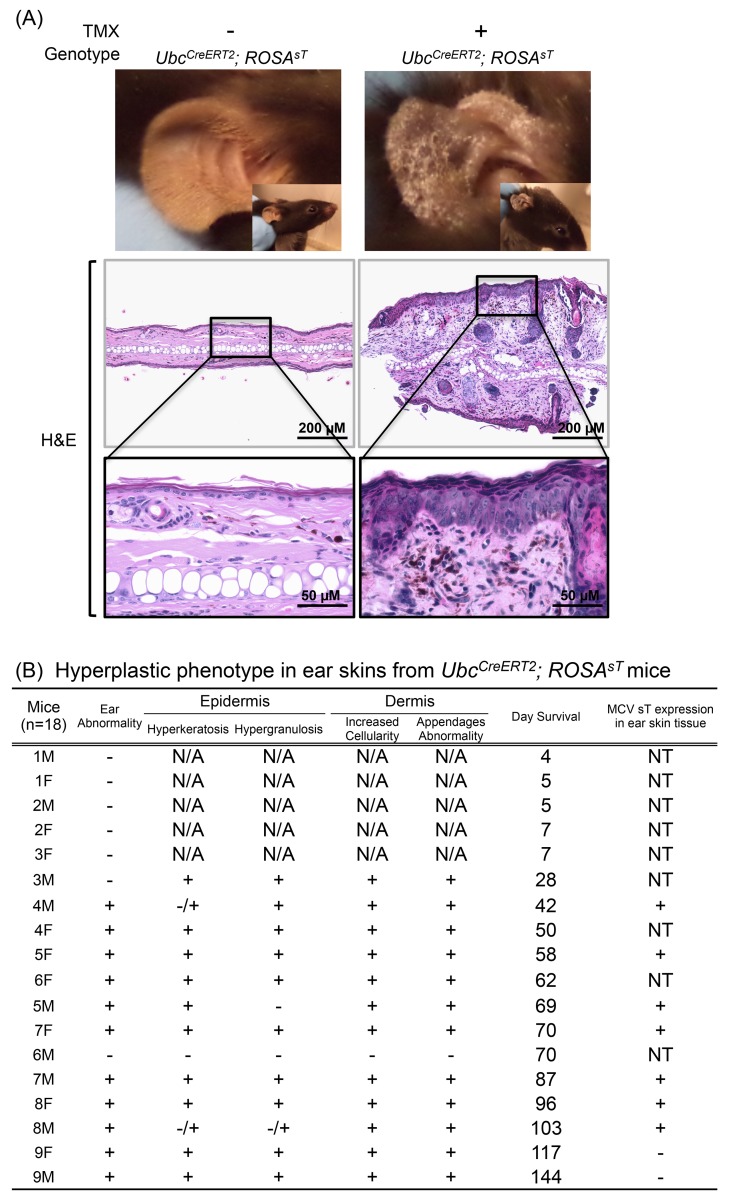
MCV sT induces hyperproliferaton of acral skin.(A) Hyperplastic phenotype in ear skin from Ubc
CreERT2
; ROSA
sT mice. Ear skin tissues from Ubc
CreERT2
; ROSA
sT mice were subjected to H&E staining. (B) Hyperproliferative phenotype in ear skin of Ubc
CreERT2
; ROSA
sT mice. H&E stained ear skin sections from low-dose TMX injected Ubc
CreERT2
; ROSA
sT and ROSA
sT mice were randomized and evaluated in a blinded manner by two pathologists for hyperkeratosis/hypergranulosis in the epidermis and increased cellularity/appendage abnormalities. N/A: not available since ear tissues were normal and not harvested. NT: not tested.